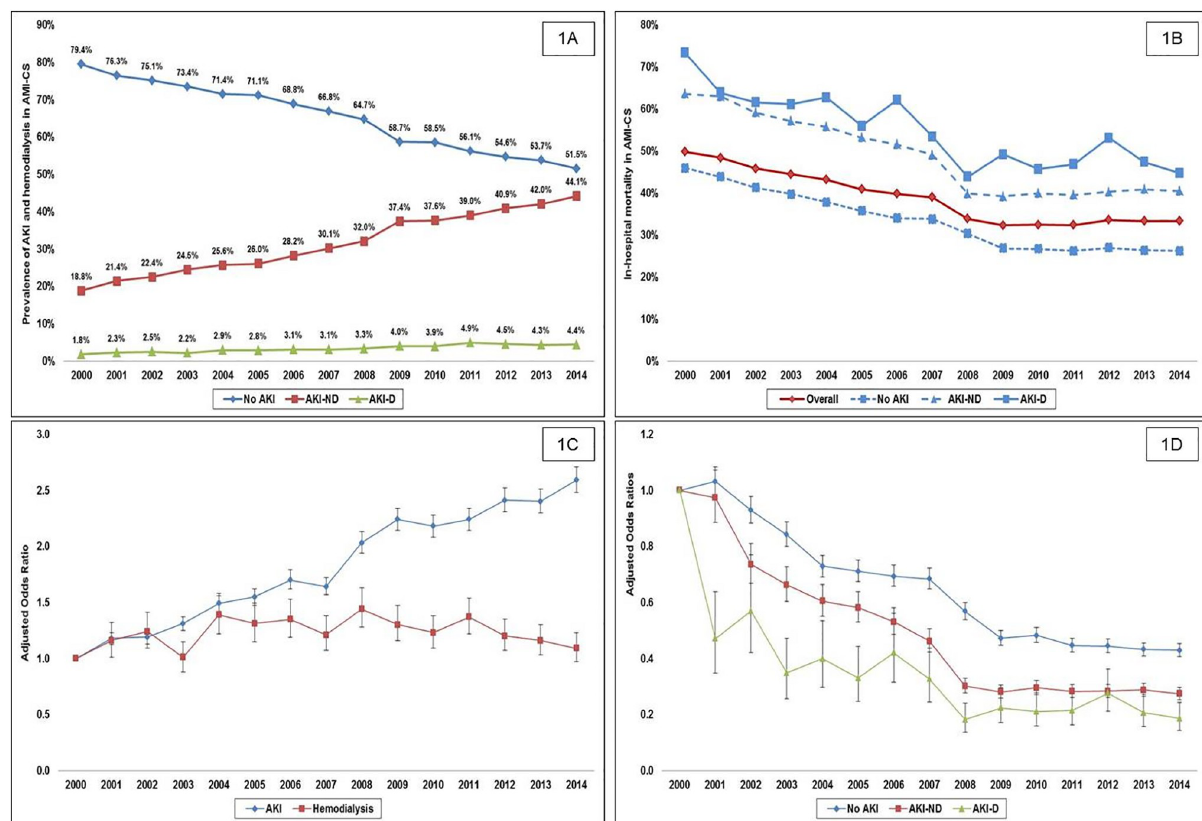
Fig 1. Unadjusted and adjusted temporal trends of the incidence and in-hospital mortality of acute kidney injury and hemodialysis in AMI-CS. 1A: Unadjusted fifteen-year temporal trends of no AKI, AKI-ND, AKI-D in AMI-CS; 1B: Unadjusted fifteen-year temporal trends of in-hospital mortality in the cohorts of no AKI, AKI-ND, AKI-D in AMI-CS; 1C: Adjusted temporal trends for the incidence of AKI, hemodialysis use in AMI-CS � ; 1D: Adjusted temporal trends for in-hospital mortality in cohorts with no AKI, AKI-ND and AKI-D in AMI-CS � ; all p < 0.001 for trend. � Adjusted for: age, sex, race, primary payer, socio-economic status, hospital location/teaching status, hospital bedsize, hospital region, comorbidity, acute organ dysfunction, cardiac arrest, use of coronary angiography, percutaneous coronary intervention, invasive hemodynamic assessment, mechanical circulatory support and invasive mechanical ventilation. Abbreviations: AKI: acute kidney injury; AKI-D: acute kidney injury requiring hemodialysis; AKI-ND: acute kidney injury with no need for hemodialysis; AMI: acute myocardial infarction; CS: cardiogenic shock.